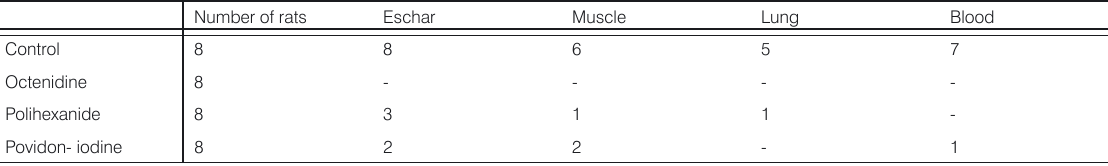
Table 1. Frequency of recovery of seeded organisms from each culture site.